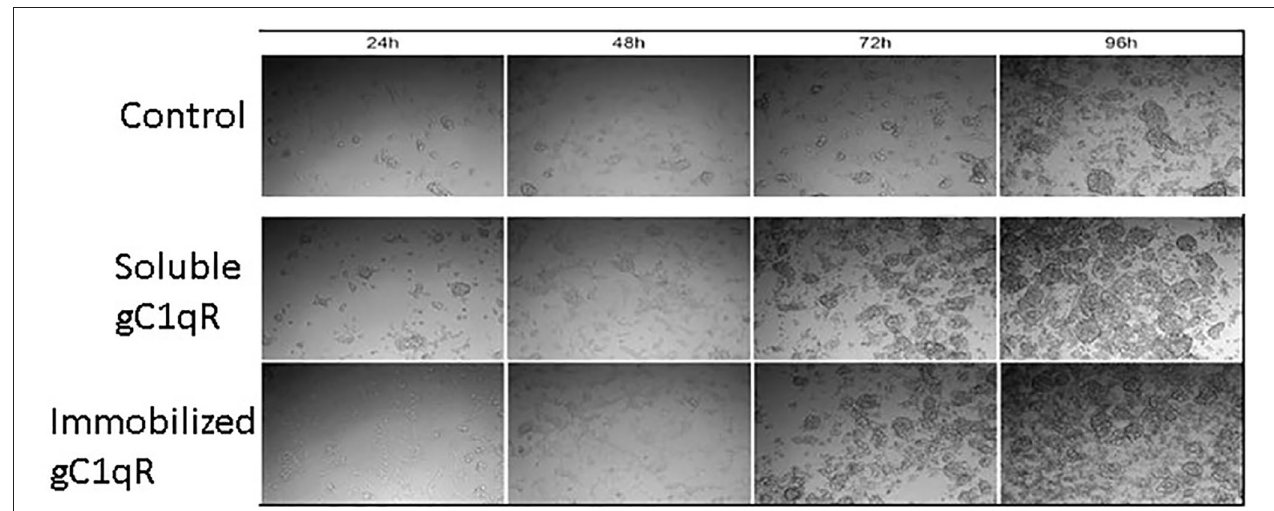
FIGURE 3 | Extracellular gC1qR enhances MSTO-211H cell growth in culture. Tissue culture wells were coated with gC1qR or coating buffer (control) and seeded with MSTO-211H cells. Cells were supplemented with recombinant gC1qR (5 µ g/ml) as noted. Cell cultures were imaged at 24-h intervals via compound light microscopy (10 × magnification). Representative images are shown. Increased cell growth is evident at 72 and 96h in the presence of soluble or immobilized extracellular gC1qR.